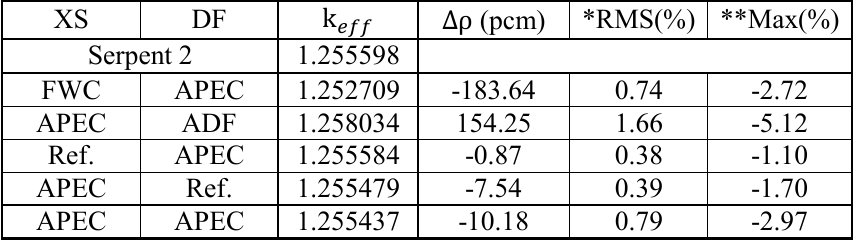
Table Ⅲ . Results of color-set-based APEC functions.